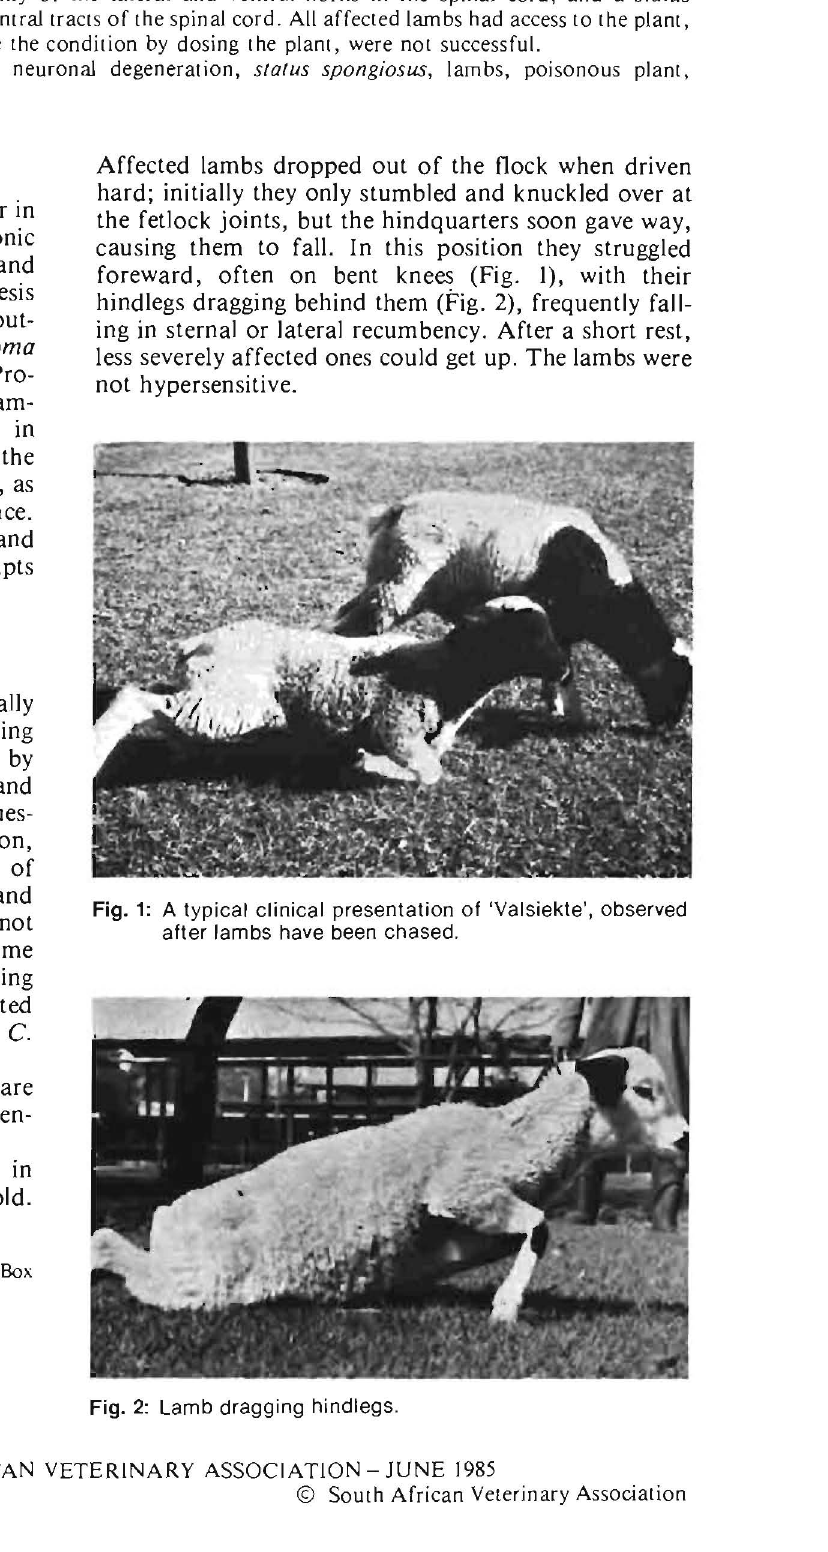
Fig. 2: Lamb dragging